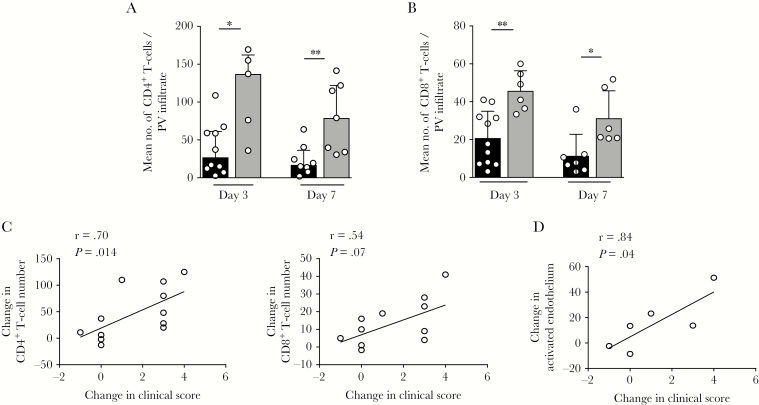
Zostavax vaccination leads to an increase in T-cell accumulation at the site of varicella zoster virus (VZV) antigen challenge. Punch biopsy specimens (diameter, 5 mm) were obtained on days 3 and 7 after VZV antigen challenge, before and after vaccination. A and B, Cumulative data showing number of CD4+ (A) and CD8+ (B) T cells per perivascular (PV) infiltrate before (black) and after (gray) vaccination on days 3 and 7 after VZV antigen challenge. C, Correlation between change in CD4+ (left) and CD8+ (right) T-cell number and change in clinical score after vaccine administration. D, Correlation between change in activated endothelium (calculated as the percentage of CD31+ loops expressing E-selectin) and change in clinical score after vaccine administration. For panels A and B, data were assessed by the Mann-Whitney test. For panels C and D, data were assessed by the Pearson correlation test.